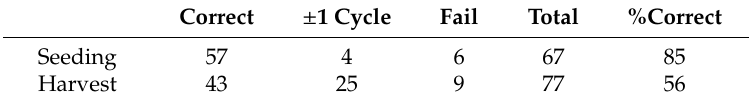
Table 2. Results for seeding and harvest detection.